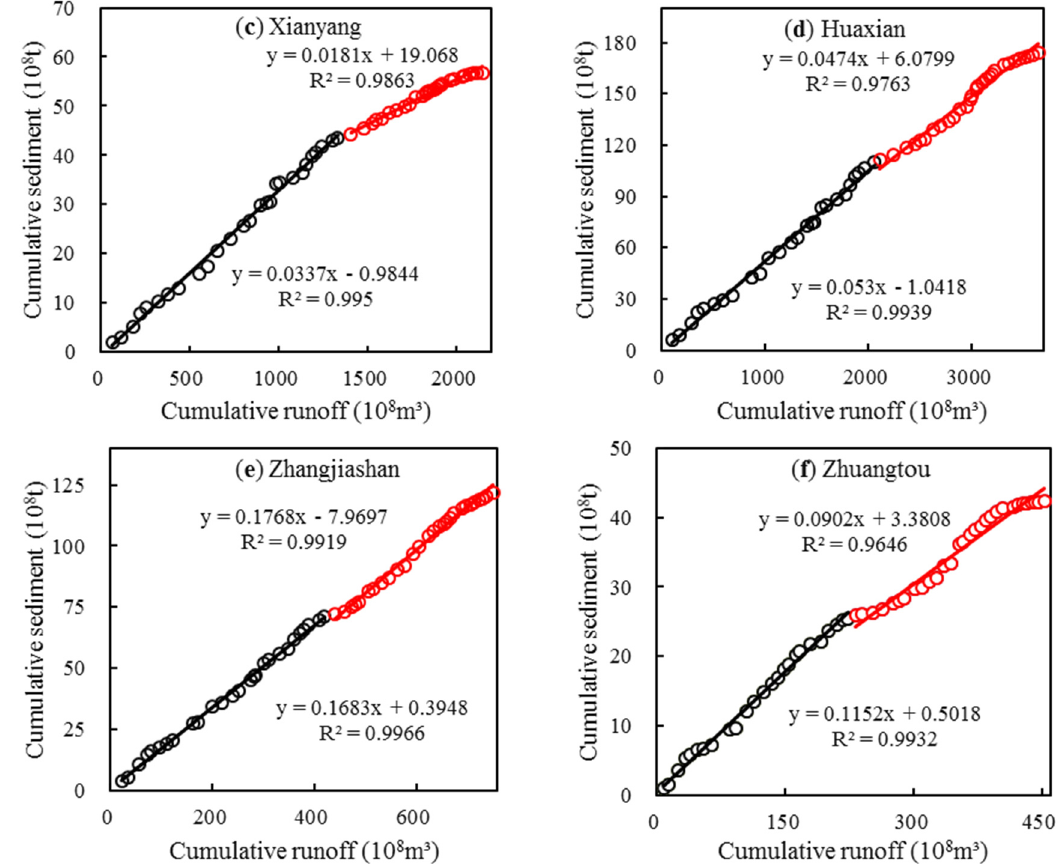
Figure 3. The double mass curves of annual runoff and sediment for the hydrological stations in the WRB. ( a ) Linjiacun station; ( b ) Weijiabu station; ( c ) Xianyang station; ( d ) Huaxian station; ( e ) Zhangjiashan station; ( f ) Zhuangtou station.